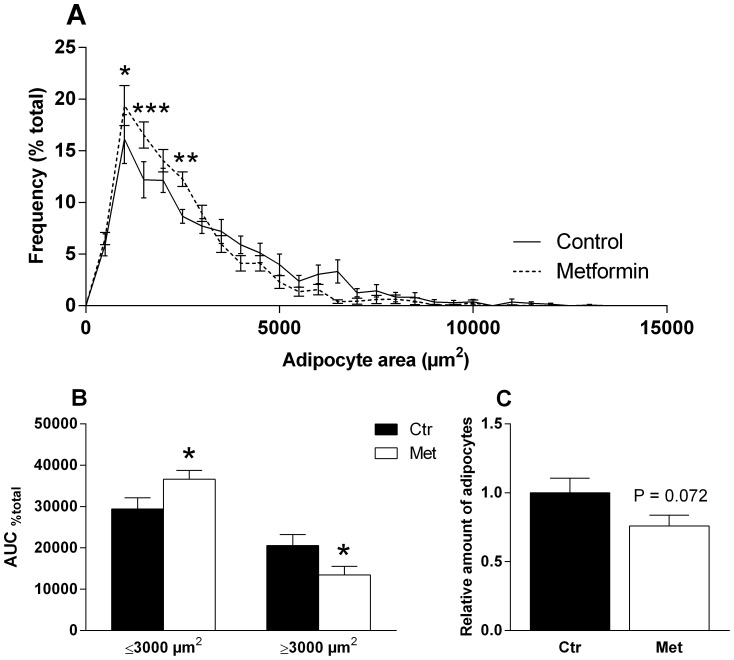
Adipocyte size distribution in gWAT at the end of the postnatal HFD phase.The percentage of the adipocytes on every 500 µm2. * = P<0.05, ** = P<0.01 and *** = P<0.001 by 2-way ANOVA and Sidak's multiple comparisons test (A). AUC of the adipocyte size distribution curve ≤3000 µm2 and ≥ 3000 µm2 (B). Relative amount of adipocytes (C). n = 11–14. * = P<0.05 by Student's t-test.